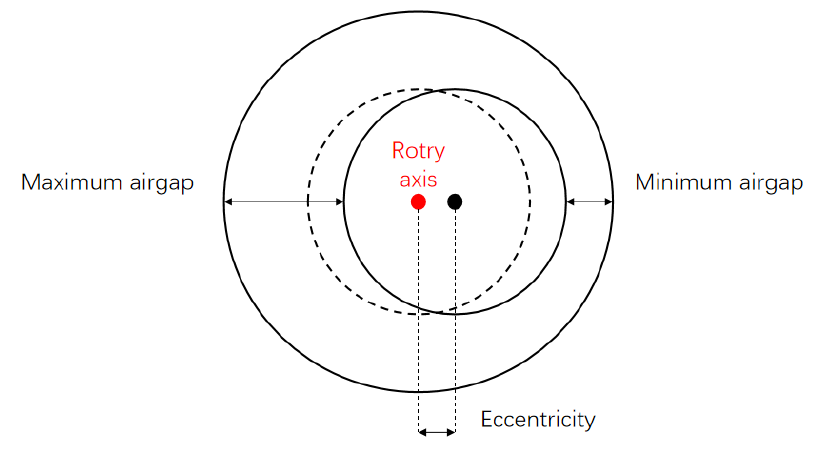
Figure 6. The rotor eccentricity model with 0.15 mm deviation.